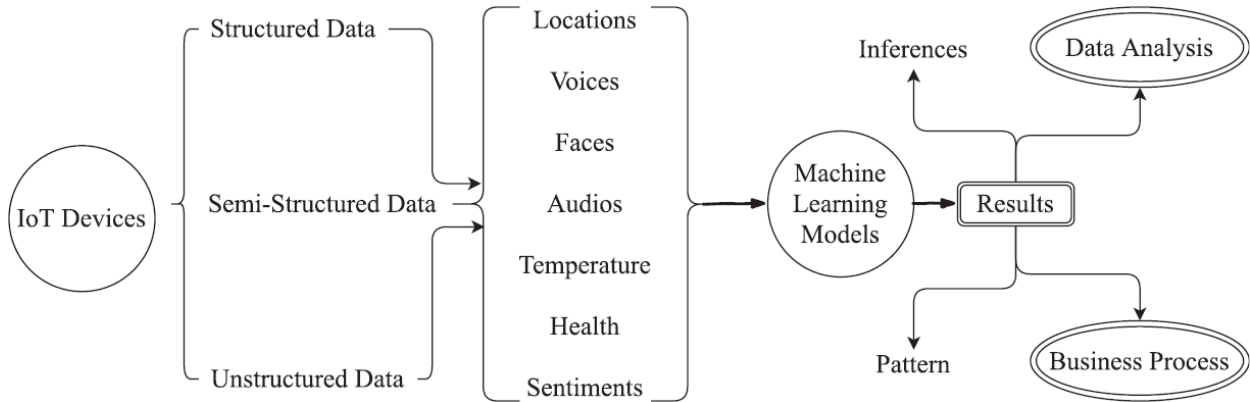
Figure 10. The basic machine learning-based model integration with the